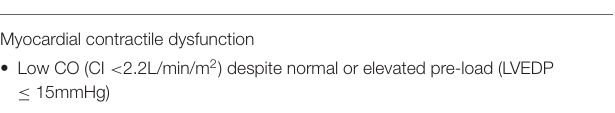
TABLE 1 | Characteristic features of cardiogenic shock. Clinical features of cardiogenic shock Myocardial contractile dysfunction